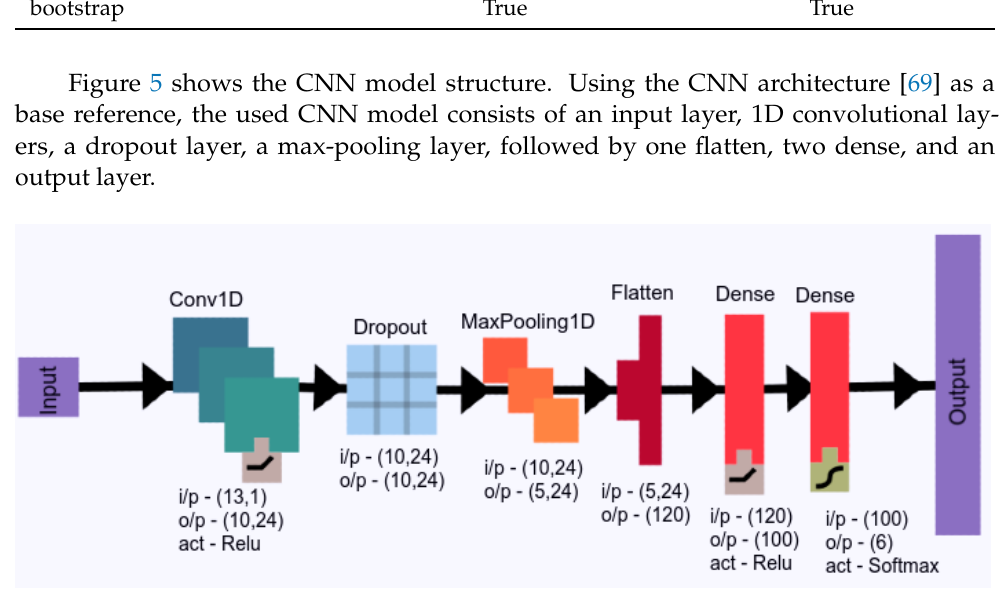
Figure 5. Proposed Convolutional Neural Network (CNN)